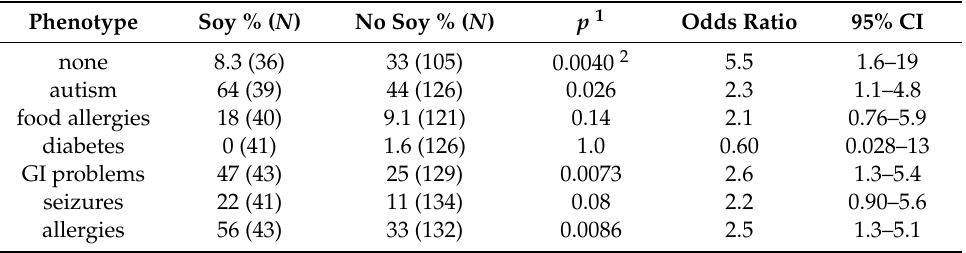
Table 5. Analysis of FXS comorbidities as a function of soy-based infant